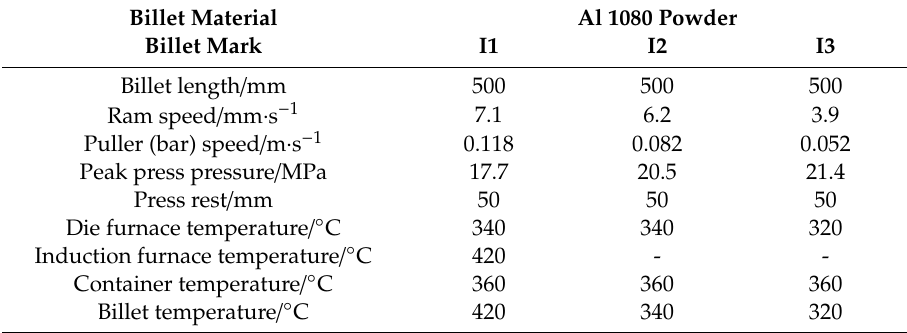
Table 3. Extrusion parameters used for 35 MN indirect-extrusion